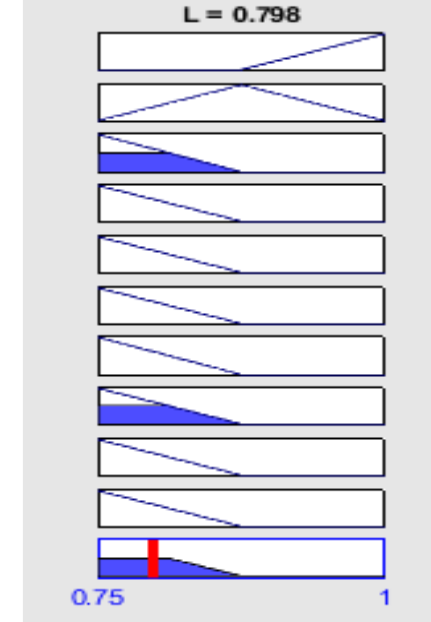
Figure 6 – Fuzzy output of smart street lighting Рис. 6 – Нечеткий вывод умного уличного освещения Слика 6 – Фазни излаз паметног уличног осветљења